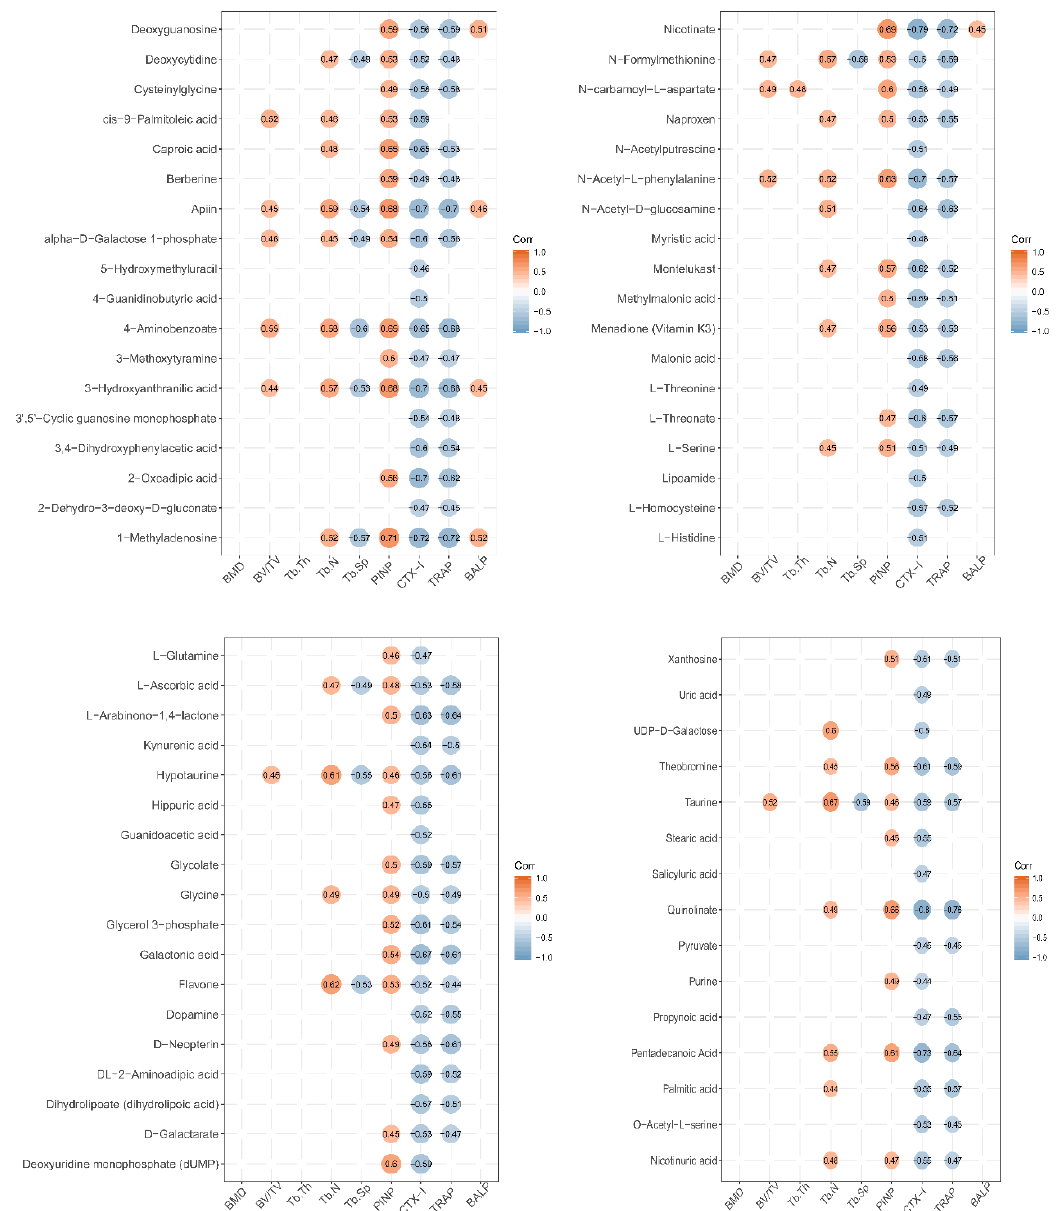
Figure 5. Correlation between expression level of urine metabolites and bone status in LF-supplemented rats. Pearson correlation analysis was used to assess the relationship between expression levels of urine metabolites and bone status (CTX-1, TRACP, PINP, BALP, BMD, BV / TV, Tb.Th, Tb.Sp, and Tb.N). Pearson correlation is significantly different at a level of 0.05, and they are not shown in the graph when p ≥ 0.05. Red circle represents positive correlation, and blue circle represents negative correlation. The value in circle represents Pearson correlation coefficient r.